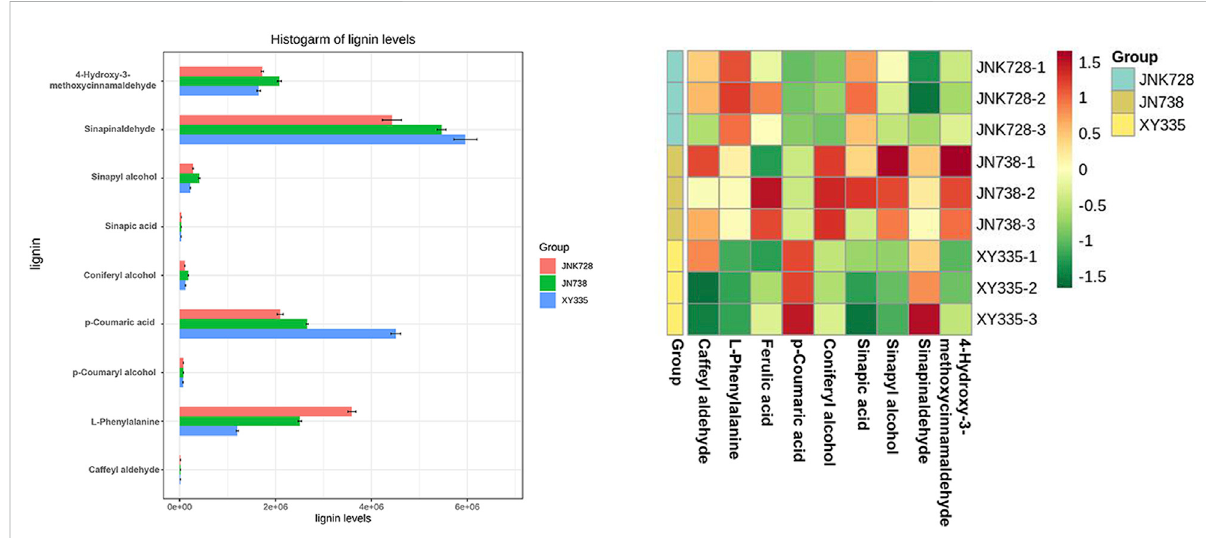
FIGURE 6 Lignin content quanti fi cation in the samples of the three maize hybrid cultivars. The bar graphs on the left show the lignin content of each cultivar, and the plot on the right is the cluster heat map of the lignin